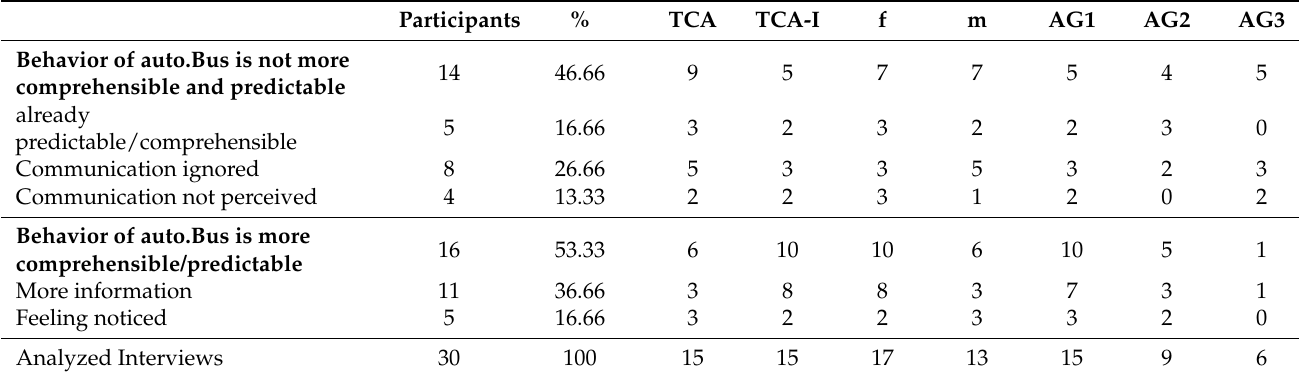
Table A3. Comprehensibility and Predictability of the Situation.